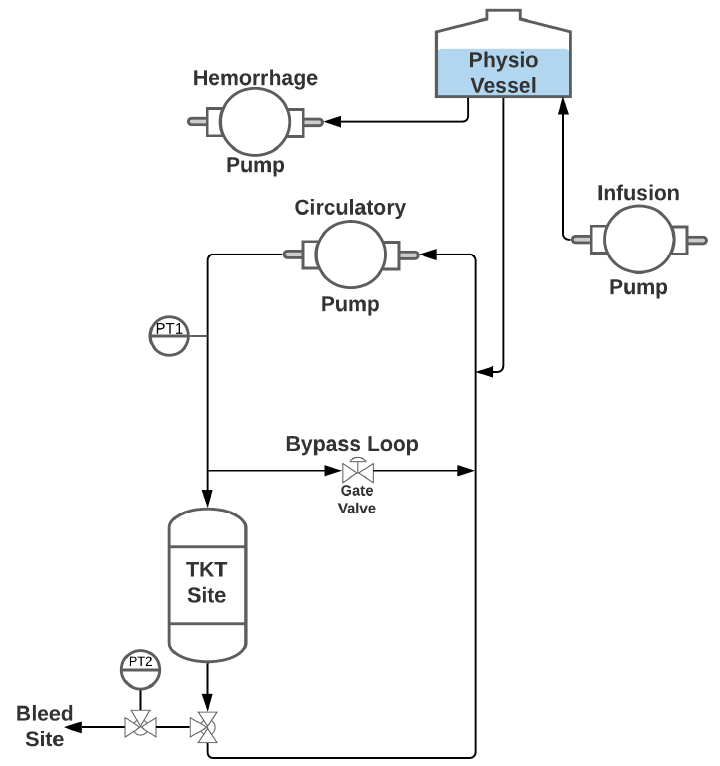
Figure 2. Diagram of the PhysioVessel flow loop test platform. A peristaltic pump (labeled Circula- tory Pump) provided pulsatile flow, which was read by a pressure transducer (PT1) mimicking ar- terial line placement. Flow passed through an arm analogue made of silicone where a tourniquet was placed, and an extremity bleed was started distal to the arm; a second pressure readout was collected at the hemorrhage site (PT2). Arm and bypass flow streams merged upstream from the PhysioVessel, followed by completing the loop at the circulatory pump. Internal hemorrhage was pulled directly from the PhysioVessel by a peristaltic pump (labeled Hemorrhage Pump), and re- suscitation was managed by a third peristaltic pump (labeled Infusion Pump) by infusing directly into the PhysioVessel. 2.4. Adaptive Resuscitation Controller Experimental Design Several experiments were run to evaluate the responsiveness of ARC under various conditions (Table 1), and three replicate infusions were conducted for each scenario. One set of test scenarios examined the effects of modifying the scaling factor used when calcu- lating flow rate by ARC. Using PV WB , scaling factors of 0.5, 1 (baseline), and 2 were as- sessed with no hemorrhage occurring in the flow loop. A second set of testing scenarios observed how ARC responded while there was an ongoing hemorrhage occurring during resuscitation. The baseline scaling factor was used with the PV WB and hemorrhage rates of 120, 240, and 360 mL/min were evaluated. Lastly, resuscitation with ARC using PV C to alter the pressure-volume resuscitation curve was tested at a baseline scaling with no hem- orrhage and a 240 mL/min hemorrhage rate.